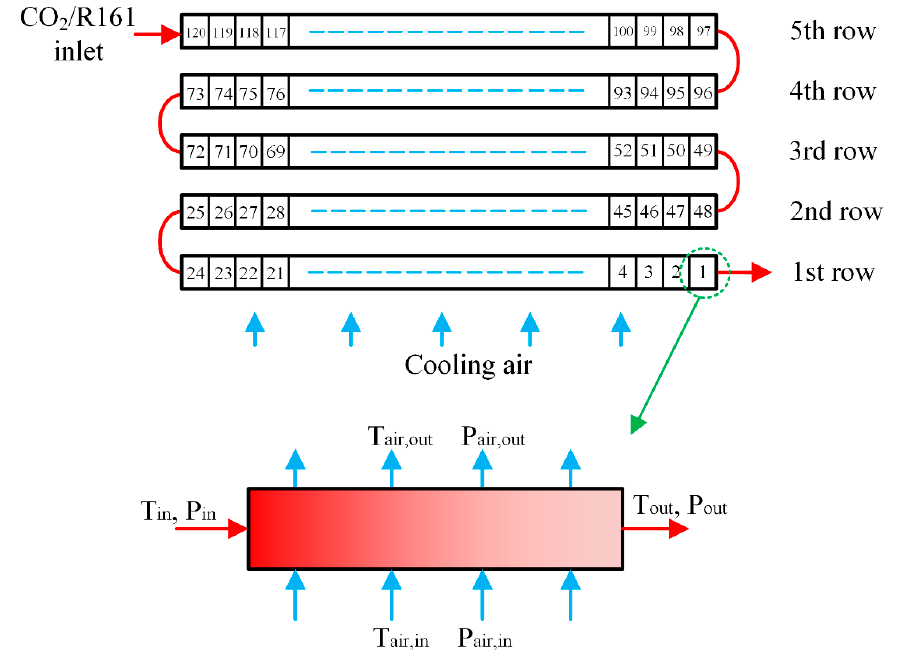
Figure 4. Heat exchanger bundles and nodal approach for the heat exchanger model.